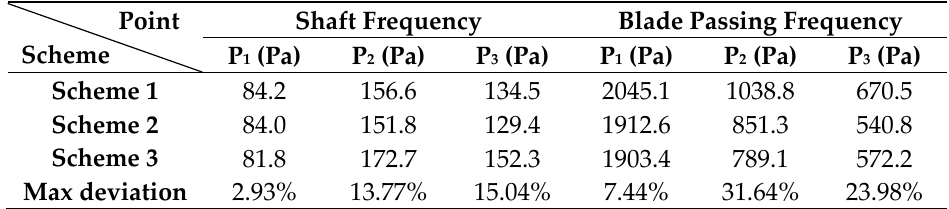
Table 2. The average of three sets of experimental